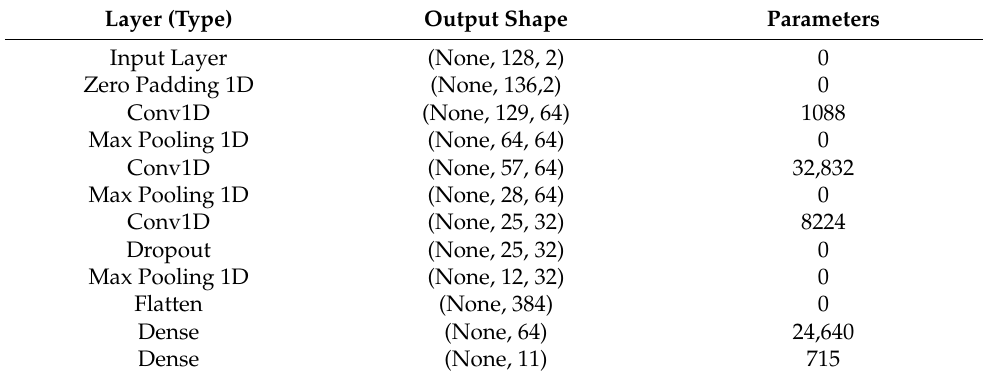
Table 5. Architecture of CNN 1D.